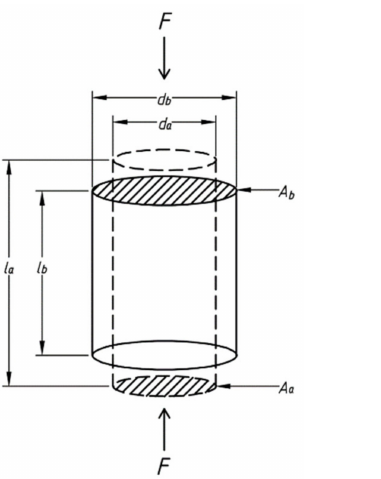
Figure 7. The schematic diagram of the specimen being